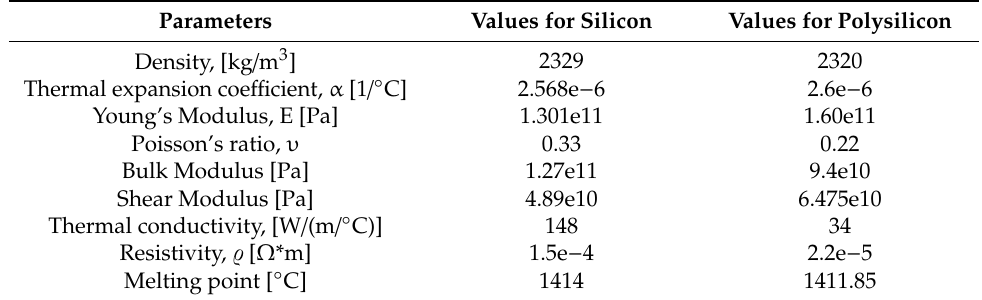
Table 2. Physical and mechanical properties of silicon [23–25] and polysilicon